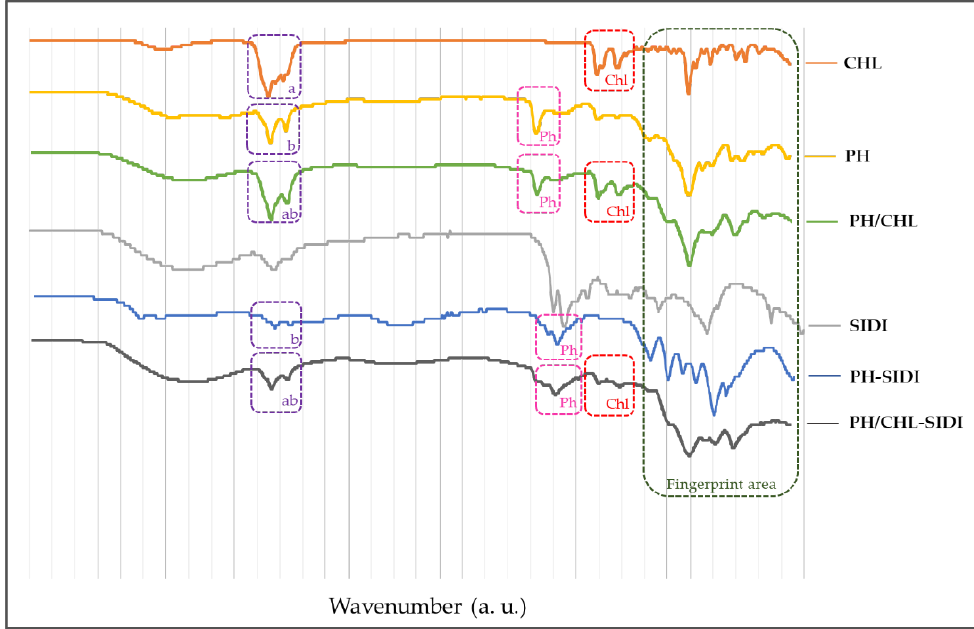
Figure 2. Specific interactions among phosphatidylcholine, cholesterol, and SIDI at PH/CHL, PH- SIDI, and PH/CHL-SIDI by FTIR spectra.